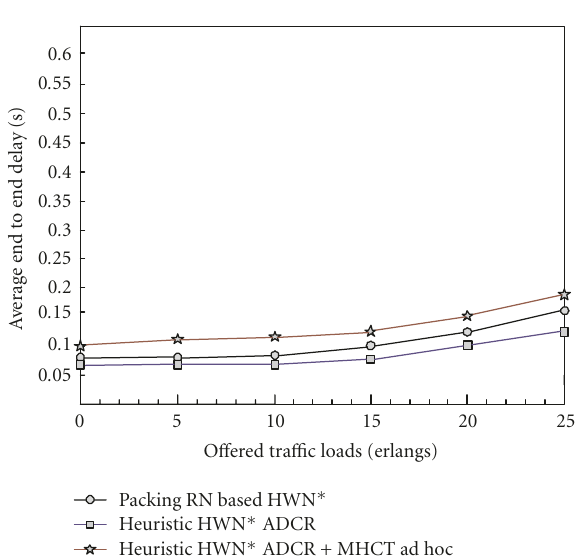
Figure 12: Average end-to-end transmission of various HWN ∗ scenarios.